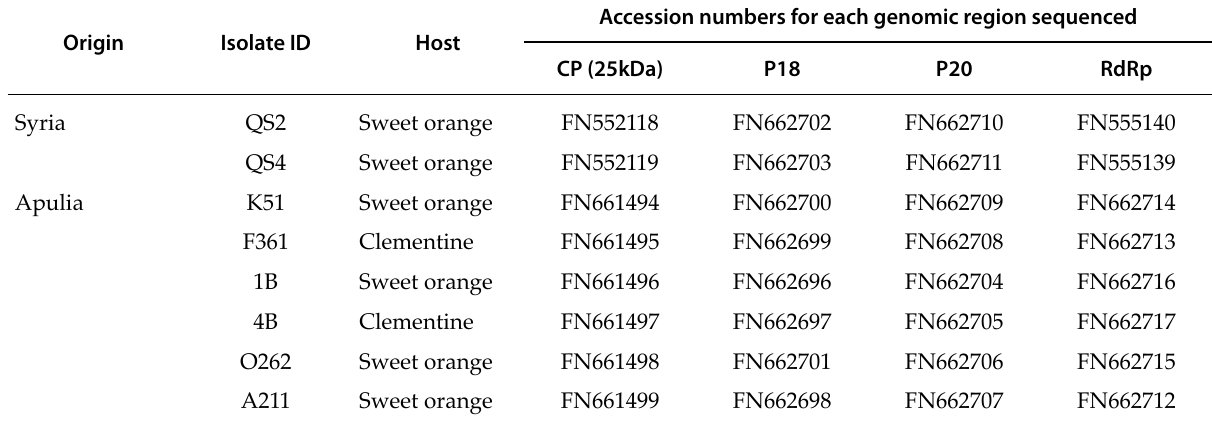
Table 3. GenBank accession numbers of nucleotide sequences of Syrian and Apulian (Italy) isolates of Citrus tristeza virus.